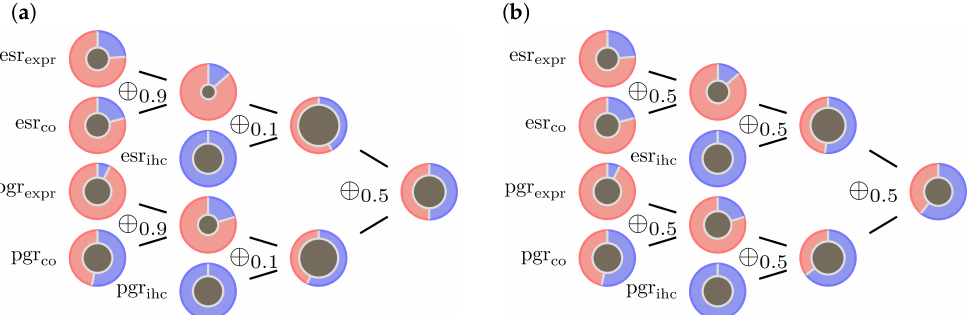
Figure 5. Contradictory data inducing undecidable outcome: ( a ) model (9) illustrated by a sample with indecisive outcome (sample id = 881). Both IHC measurements esr ihc and pgr negative, but three out of 4 pieces of evidence based on gene expression indicate a receptor positive status. Red areas represent masses α for positive hormone status, blue areas represent masses β for negative hormone status, centers represent masses θ = 1 − α − β for Ω = { + , −} . ( b ) choosing inappropriate λ for the ECRs results in dubious